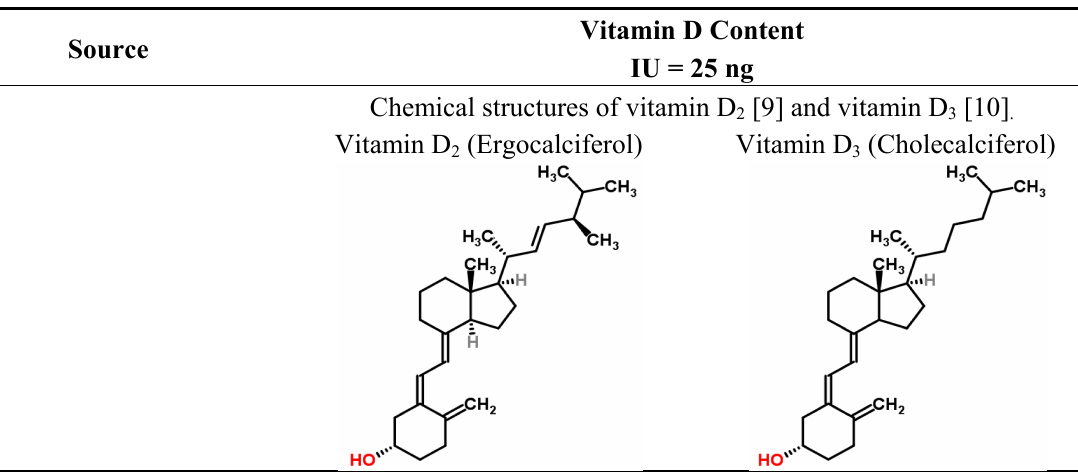
Table 1. Sources of vitamin D reproduced with permission from [7], Copyright © 2007 Massachusetts Medical